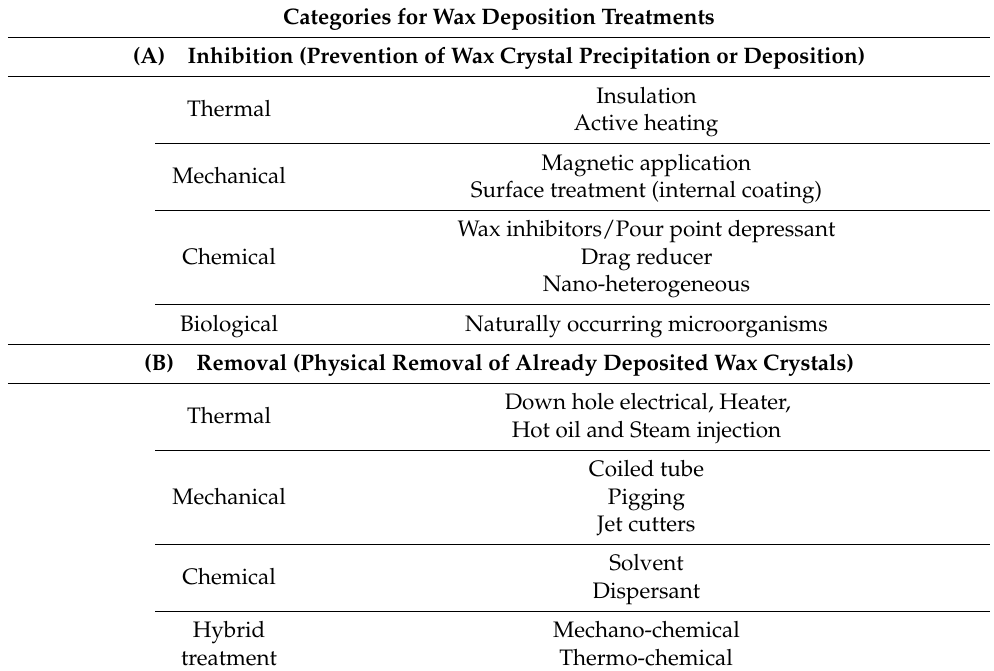
Table 1. Technologies for inhibition and removal of wax deposition, modified from